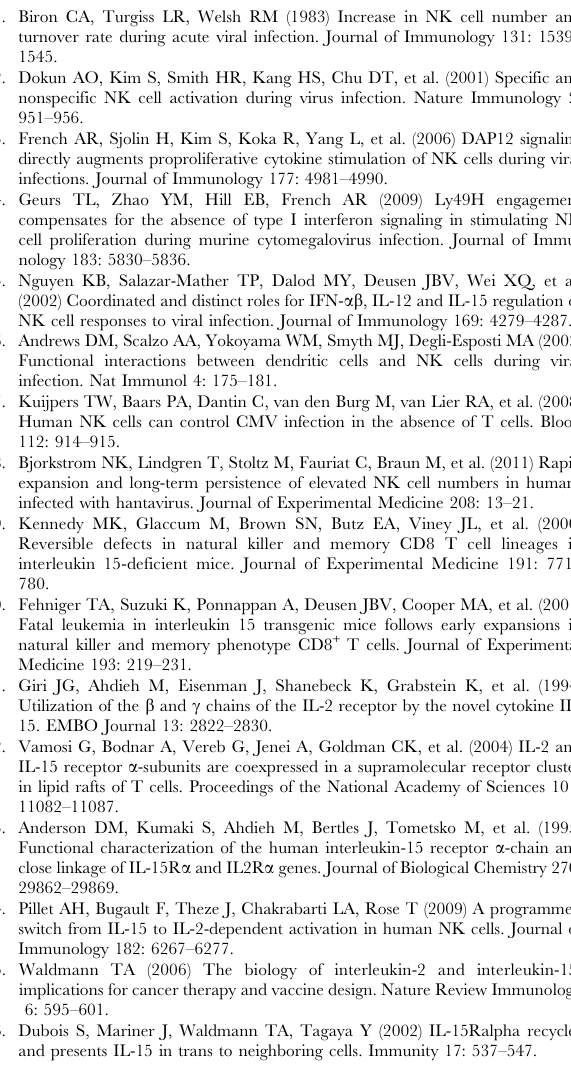
corresponding to different values of the parameter of interest were shown by the dashed curves (with the arrow representing increasing values of the parameter) while the solid curves represented the parameters at their original values. Simulations were performed for model parameters k endo ( A ), k int ( B ), k s ( C ), and k syn 9 ( D ), at an IL-15 concentration of 25 ng/ml. Figure S5 NK cell proliferation response to stimulation from a spectrum of IL-15 concentrations. A . NK cell dose response to IL-15 stimulation (3.9, 7.8, 15.6, 31.3, 62.5, 125, 250, 500, 1000, 2000 ng/ml)were shown as fraction of the maximal thymidine incorporation. Data shown represented the average of five independent experiments. B . High affinity receptor binding model simulation of the total number of surface complexes at various IL-15 concentrations (3.9, 9, 25, 50, 75, 125, 250, 500, 1000, 2000 ng/ml). C . Population mean division rate was calculated from NK cell experiments with IL-15 concentrations at 3 ng/ml (n= 3), 5 ng/ml (n =2), 9 ng/ml (n= 3), 25 ng/ml (n =3), 50 ng/ml (n= 10), 75 ng/ml (n= 3), 100 ng/ml (n =5), and 200 ng/ml (n =2).